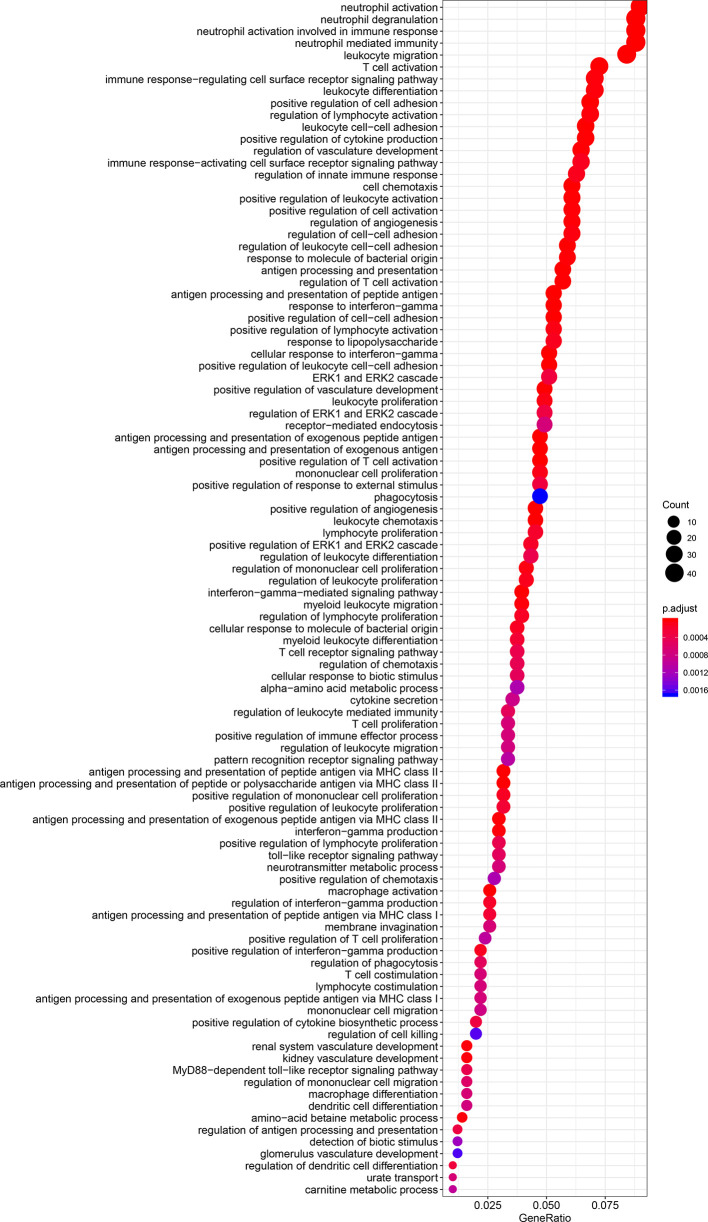
TIM-3 involves in immune regulation from the GO (Gene Ontology) analysis.